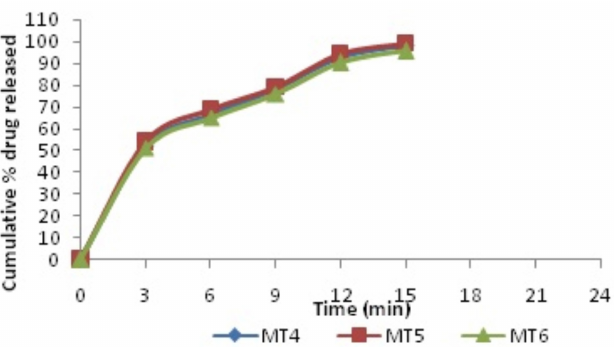
FIGURE 9 - In vitro release of metoprolol tartrate from tablets of MT4 to